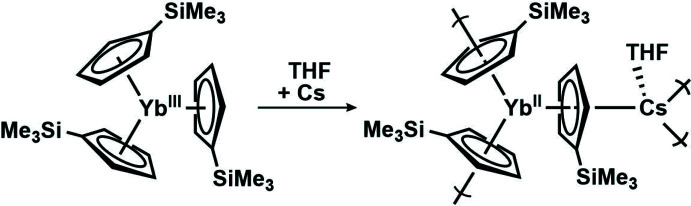
Synthesis of [(THF)Cs(μ-η5:η5-Cp′)3YbII]n, 1, by caesium metal reduction of the Cp′3YbIII precursor.